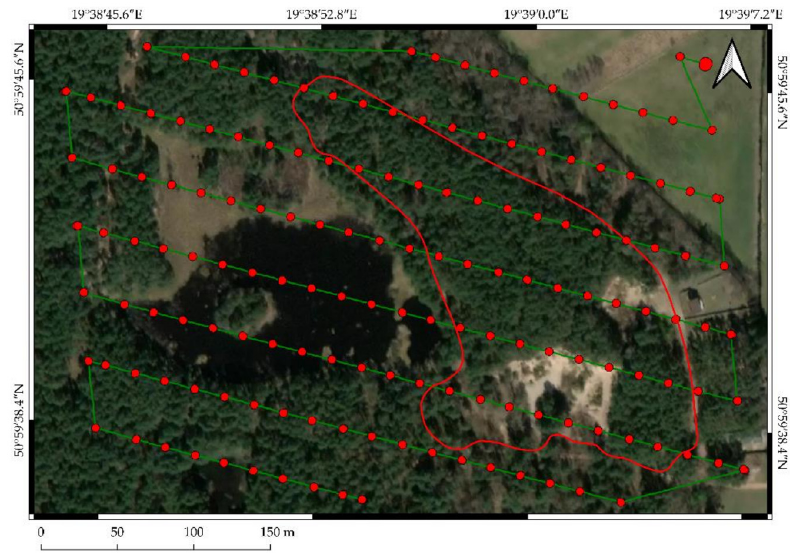
Figure 5. Top view of the initial image position capture from the UAV. The green line follows the position of the images in time, starting from the large red dot, and indicates the wind direction. The red line indicates the shape of the parabolic